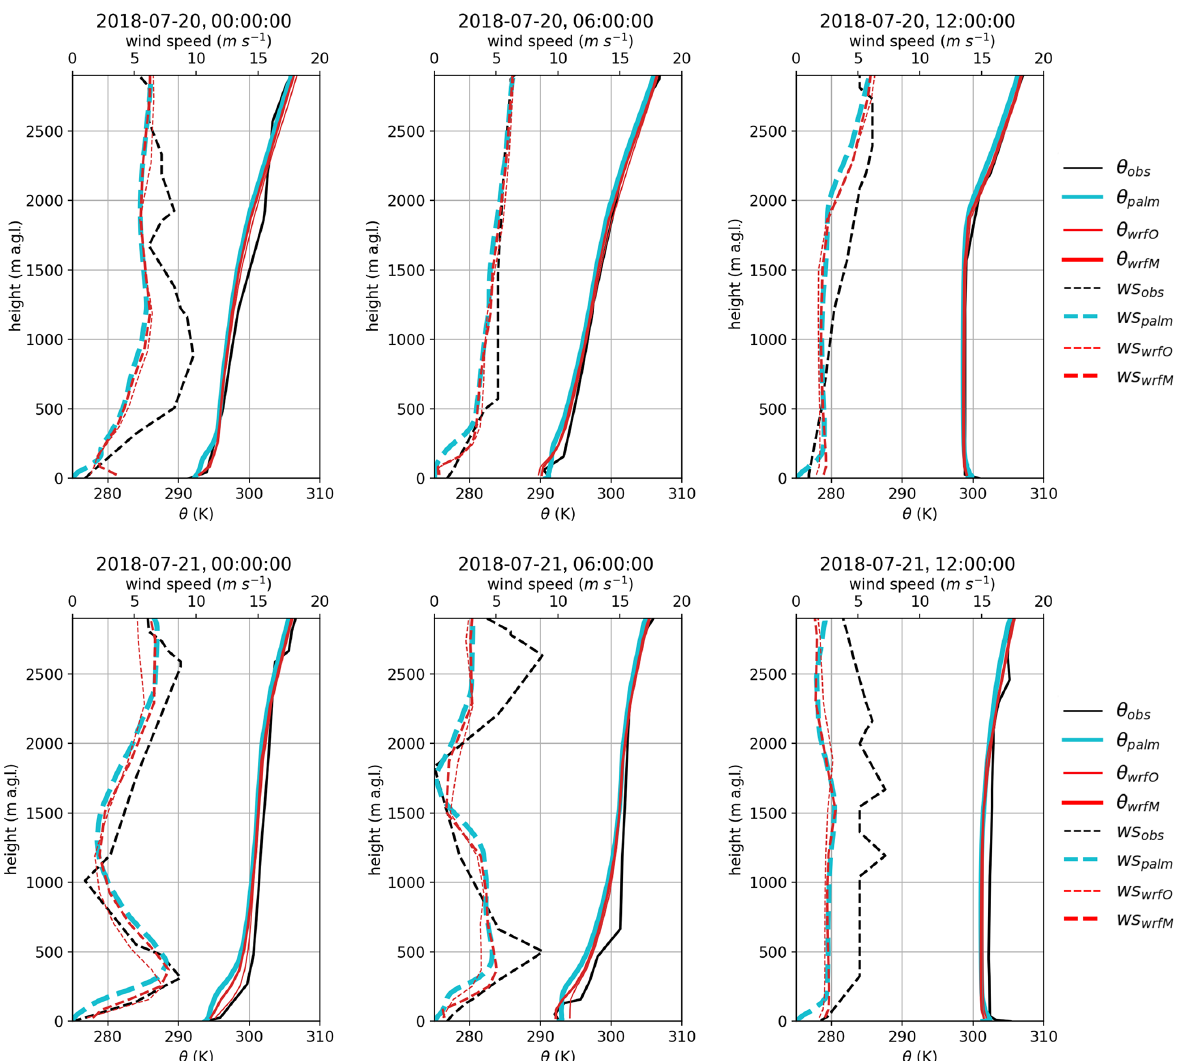
Figure 5. Vertical profiles of potential temperature and wind speed from the radiosonde observations at Praha-Libuš station for 20–21 July, with corresponding WRF (1km horizontal resolution) and PALM (average from parent 10m resolution domain) profiles. The potential temperature is represented by the solid lines, and the wind speed is denoted by the dashed lines. The black line is the sounding observation, the cyan line is the PALM model, and the red line is the WRF model. The thin red line is the WRF model at the sounding location, and the thick red line is the WRF model in the centre of the PALM